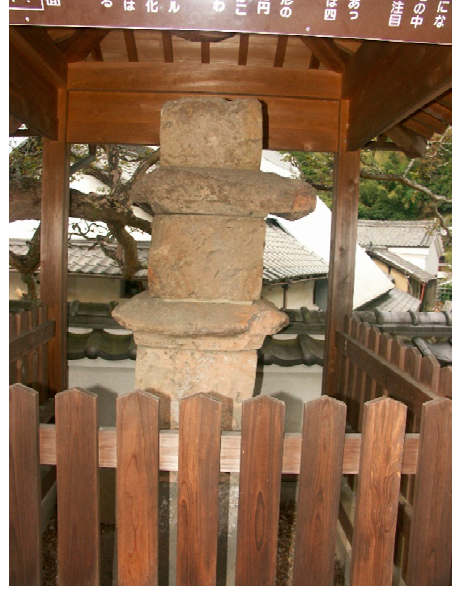
Figure 6. Ry ū fukuji’s five-story pagoda (photo).